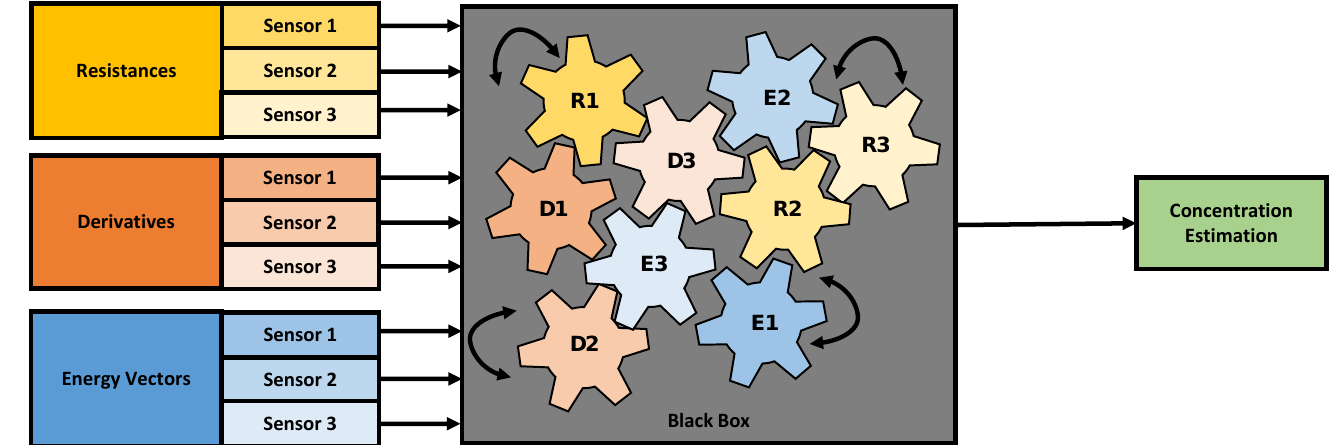
Figure 3. Illustration of a neural network as a “black box”. The input features are fed to the neural network, which then connects the different variables into a concentration